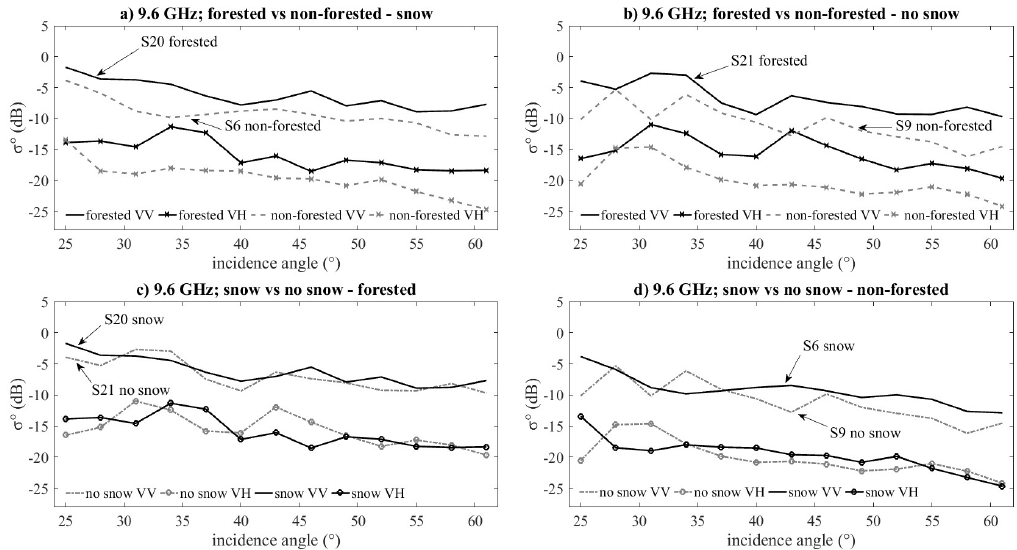
Figure 6. Comparison of 17.2 GHz backscatter response (VV and VH) as a function of the incidence angle at the Trail Valley Creek (TVC) and Grand Mesa sites. TVC sites 6 (non-forested [S6]) and 20 (forested [S20]) and sites 9 (non-forested [S9]) and 21 (forested [S21]). The figures compare the 17.2 GHz responses between the forested and non-forested sites for the ( a ) snow and ( b ) no snow cases. Also shown are the 17.2 GHz responses between the snow and no snow sites for the ( c ) forested and ( d ) non-forested cases at TVC.